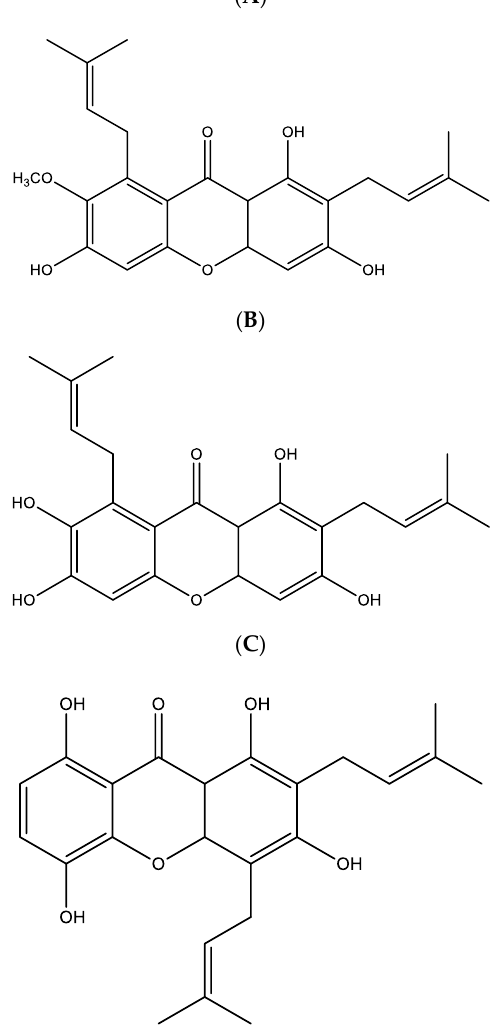
Figure 1. The Chemical structures of ( A ) α -mangostin (AM), ( B ) γ -mangostin (GM), and ( C ) gartanin (GT) [3].